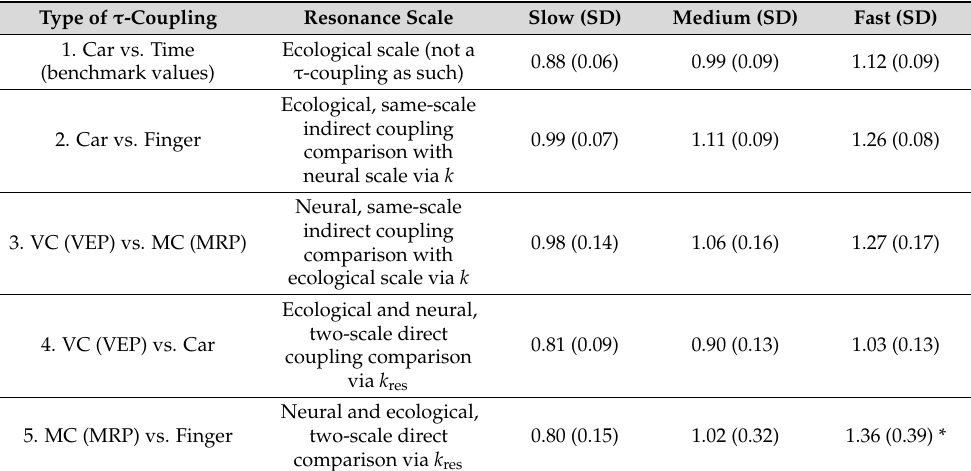
Table 1. Grand average slope values of τ -coupling constant k and k res for the three car speeds slow, medium, and fast and their standard